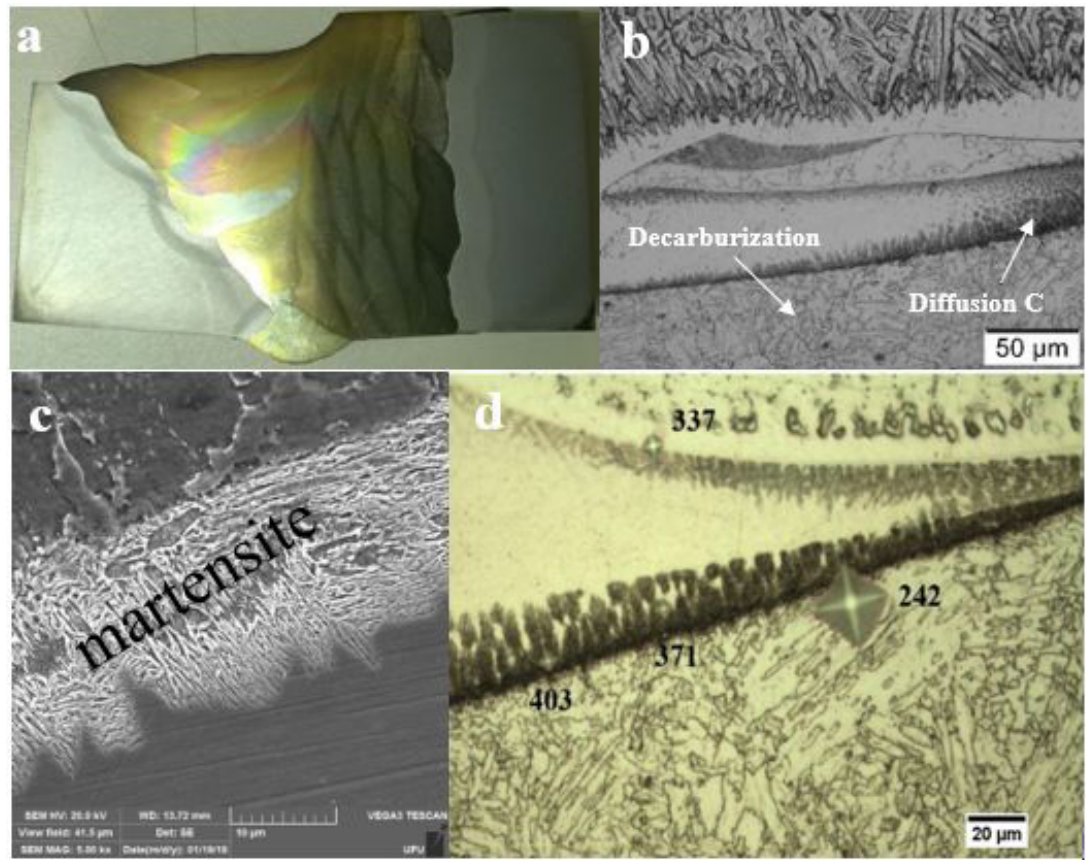
Figure 3. J625 welded joint, a) cross section macrograph, b) F22/INC625 interface, c) martensitic structure on PMZ, d) martensitic region